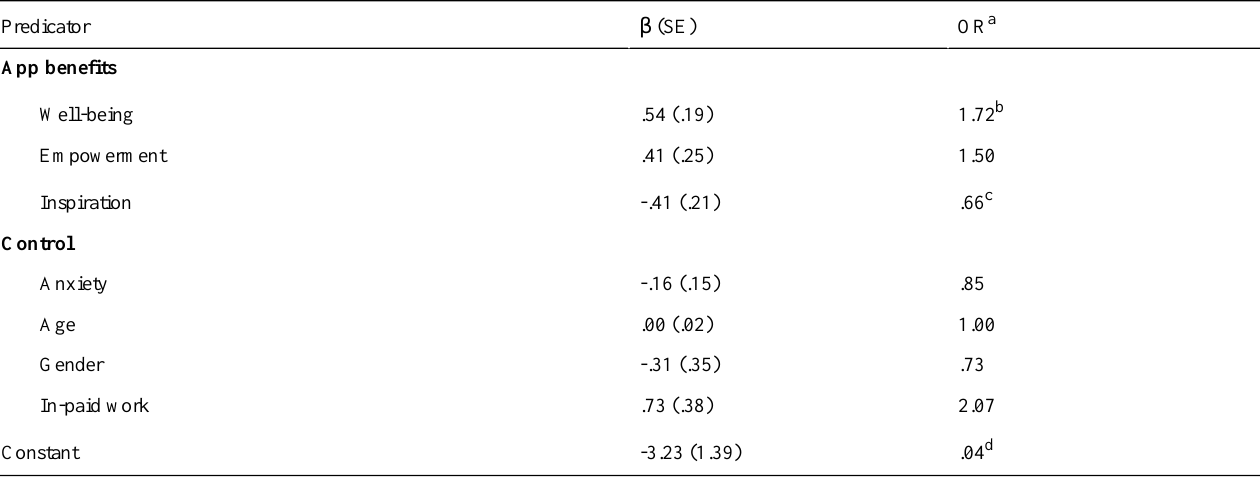
Table 4. Quitting smoking successfully after using the app ( χ 2 7 =40.4, N=190). App benefits and anxiety scored from 1 for not at all to 7 for very much . Gender scored 1 for male , 2 for female , 3 for other . In-paid work scored 1 for no , 2 for yes . Importantly, as shown in Table 5, a 1-unit increase on a 7-point Likert scale in the app’s ability to empower smokers in their daily lives led to a greater reduction in number of cigarettes smoked by 53% (beta=.53, t =3.26, P =.001). Moreover, the results showed that a 1 unit increase on a 7-point Likert scale in the app’s ability to inspire smokers led to a weaker reduction in the extent of cigarette reduction by 37% (beta=-.37, t =-2.58, P =.01).